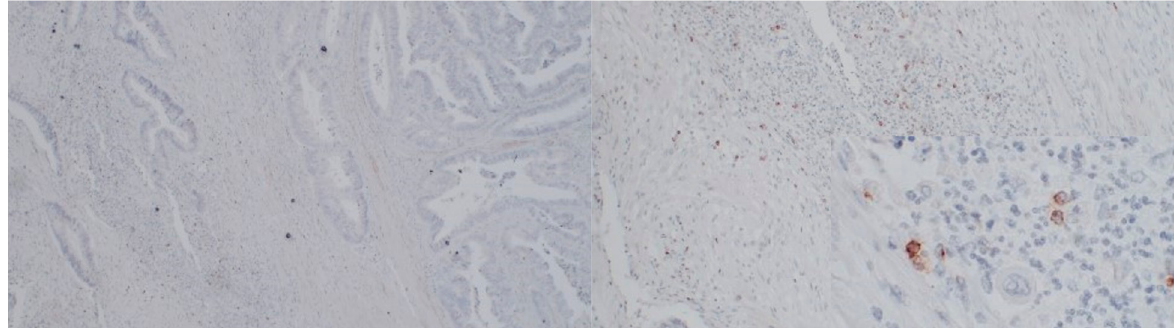
Figure 4. Immunostaining for RANTES (Opta Tech 2200 Camera, magnification 10× and 60×). Cytoplasmatic positive IHC staining for RANTES in tumor ‐ infiltrating lymphocytes.